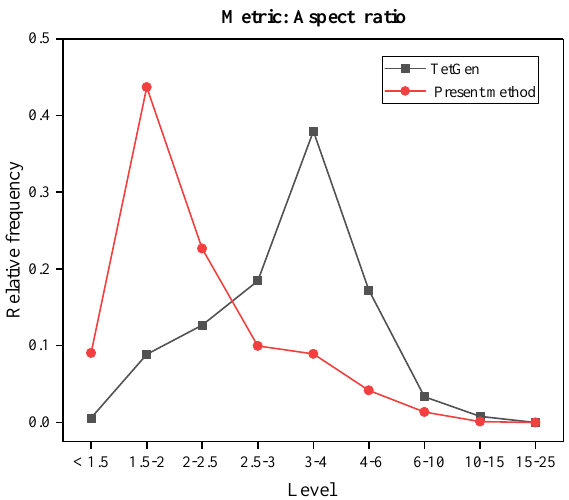
Figure 10. Statistics of the mesh quality of aspect ratio for final geological